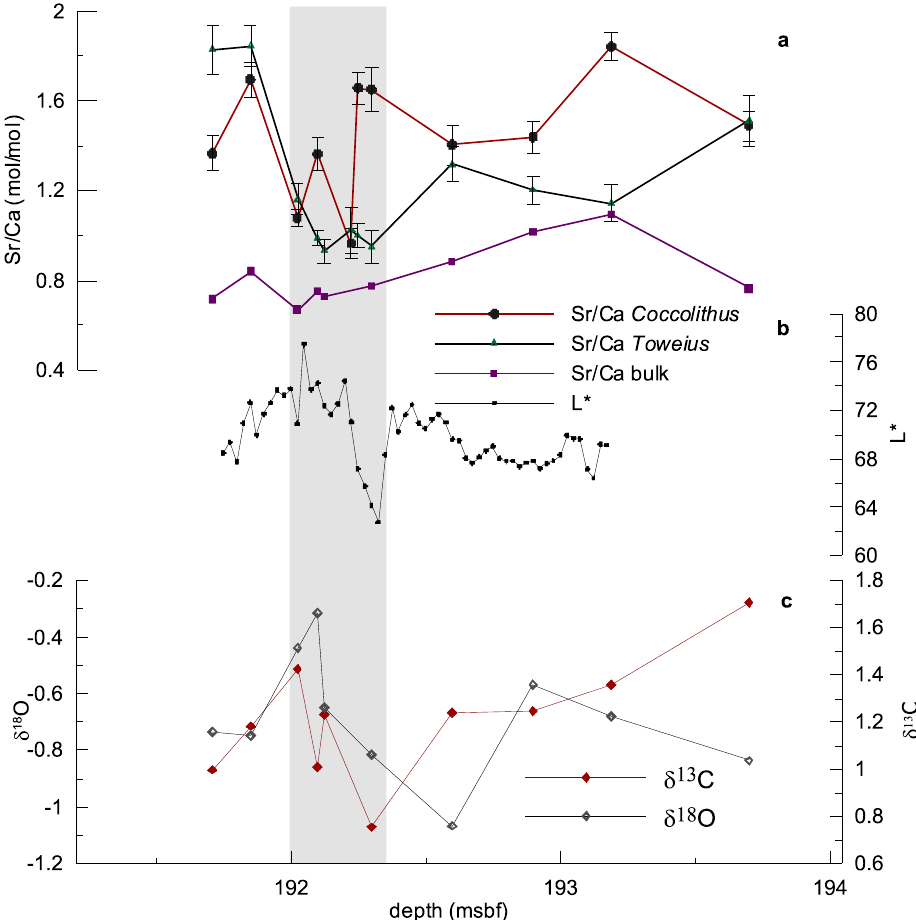
Fig. 4. (a) Sr/Ca measured in picked populations of Coccolithus and Toweius , and in bulk sediments covering ETM2 at Site 1209, (b) the L* lightness factor; color reflectance parameter that is an indicator of carbonate content (Bralower et al., 2002a), (c) the δ 13 C and δ 18 O measured in bulk carbonate. Grey bar marks the